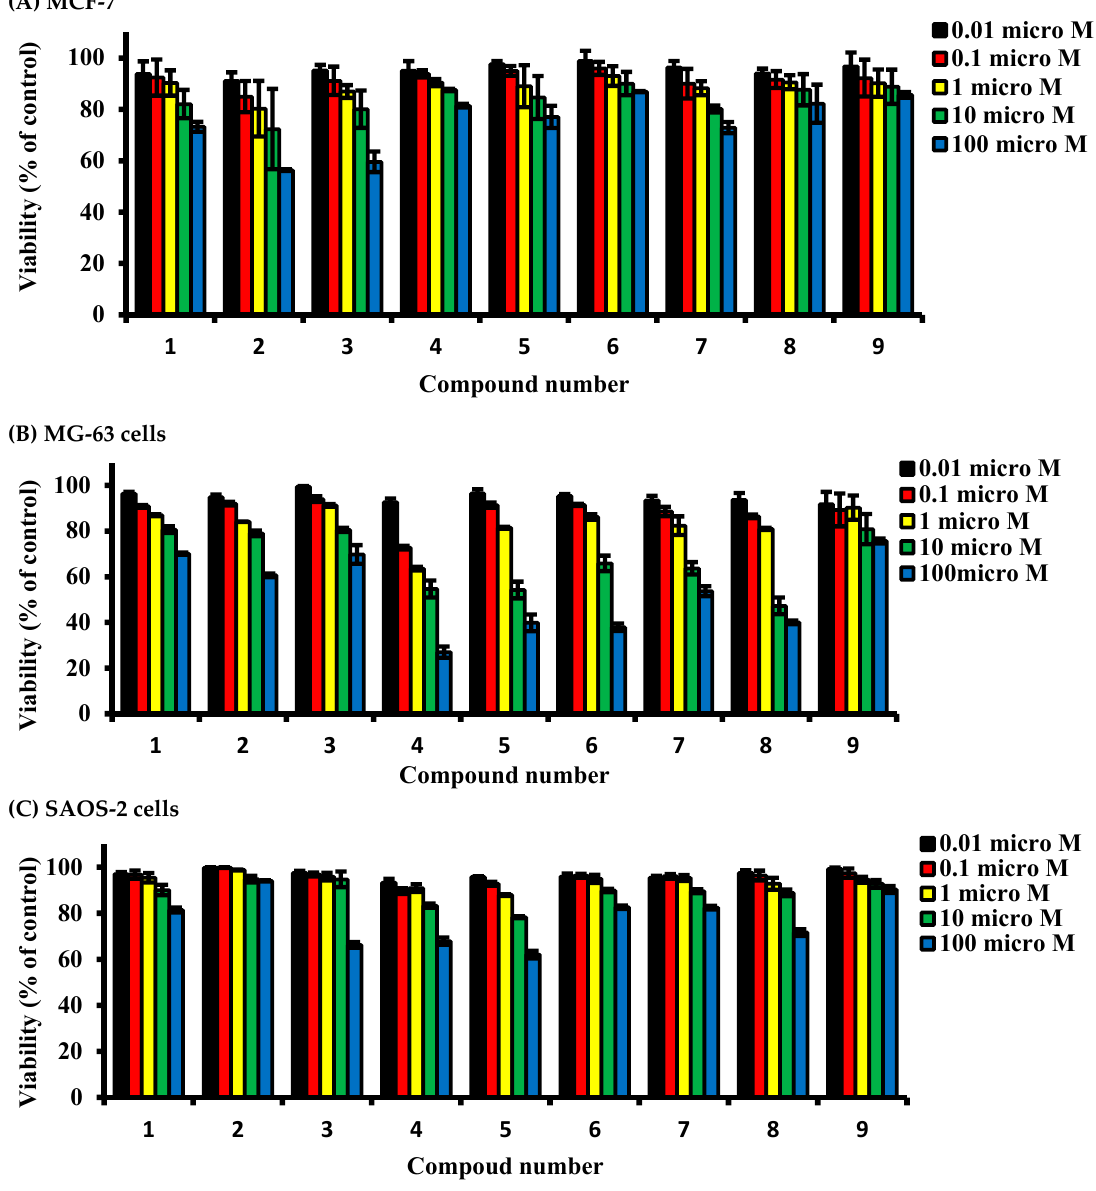
Figure 2. Dose response assessment for compounds isolated from A. meleguta against MCF-7 ( A ), MG-63 ( B ) and SAOS-2 cells ( C ). Cells were treated with test compounds for 72 h, and viability was determined using SRB assay. Data are expressed as mean ± SD; n = 6.